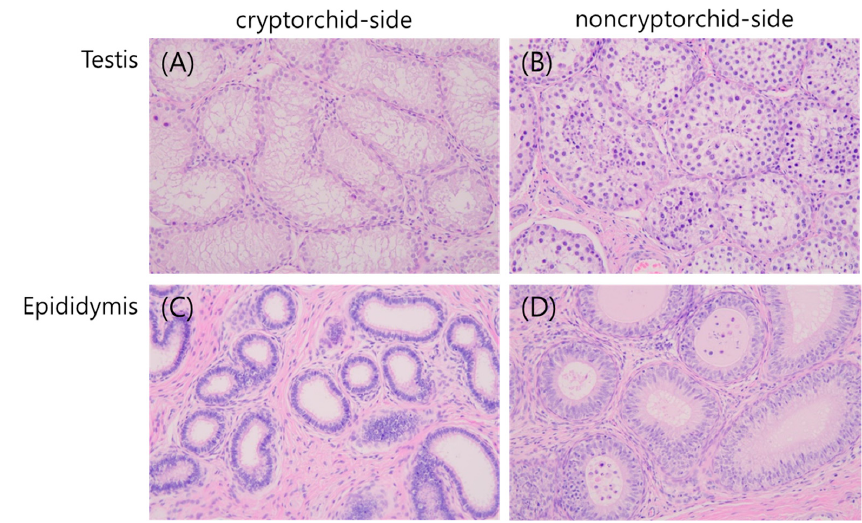
Figure 1. Images of hematoxylin and eosin-stained sections of the testis ( A , B ) and epididymis ( C , D ) in dogs with unilateral cryptorchid. The reproductive organs from the cryptorchid ( A , C ) and non-cryptorchid ( C , D ) sides were compared.